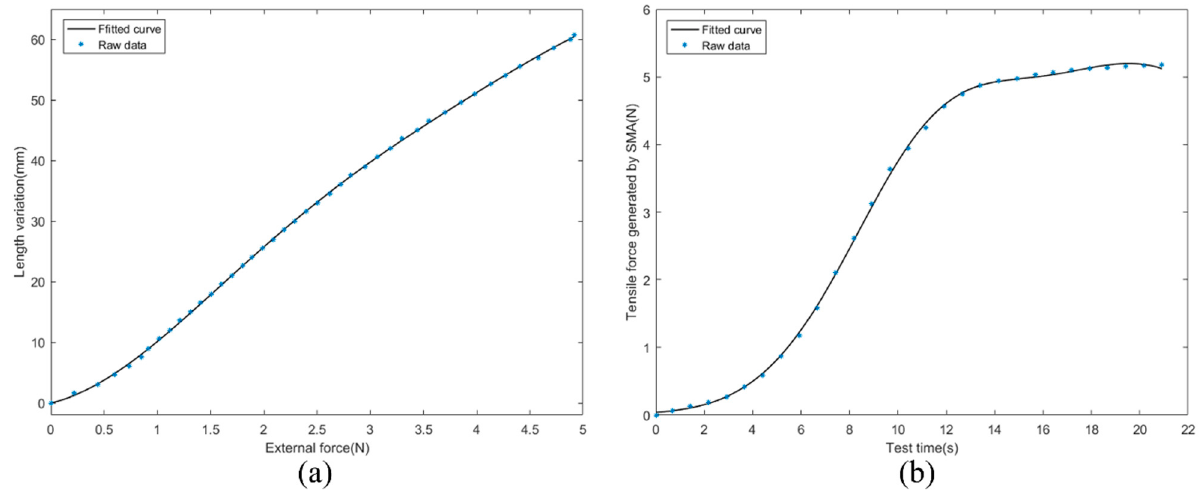
Figure 13. Passive tension and active contraction of the SMA. ( a ) When the SMA is passively stretched, the relationship between its tensile force and length change. ( b ) The relationship between the tensile force generated by SMA active contraction and the time when 2V voltage is applied at both ends of SMA.